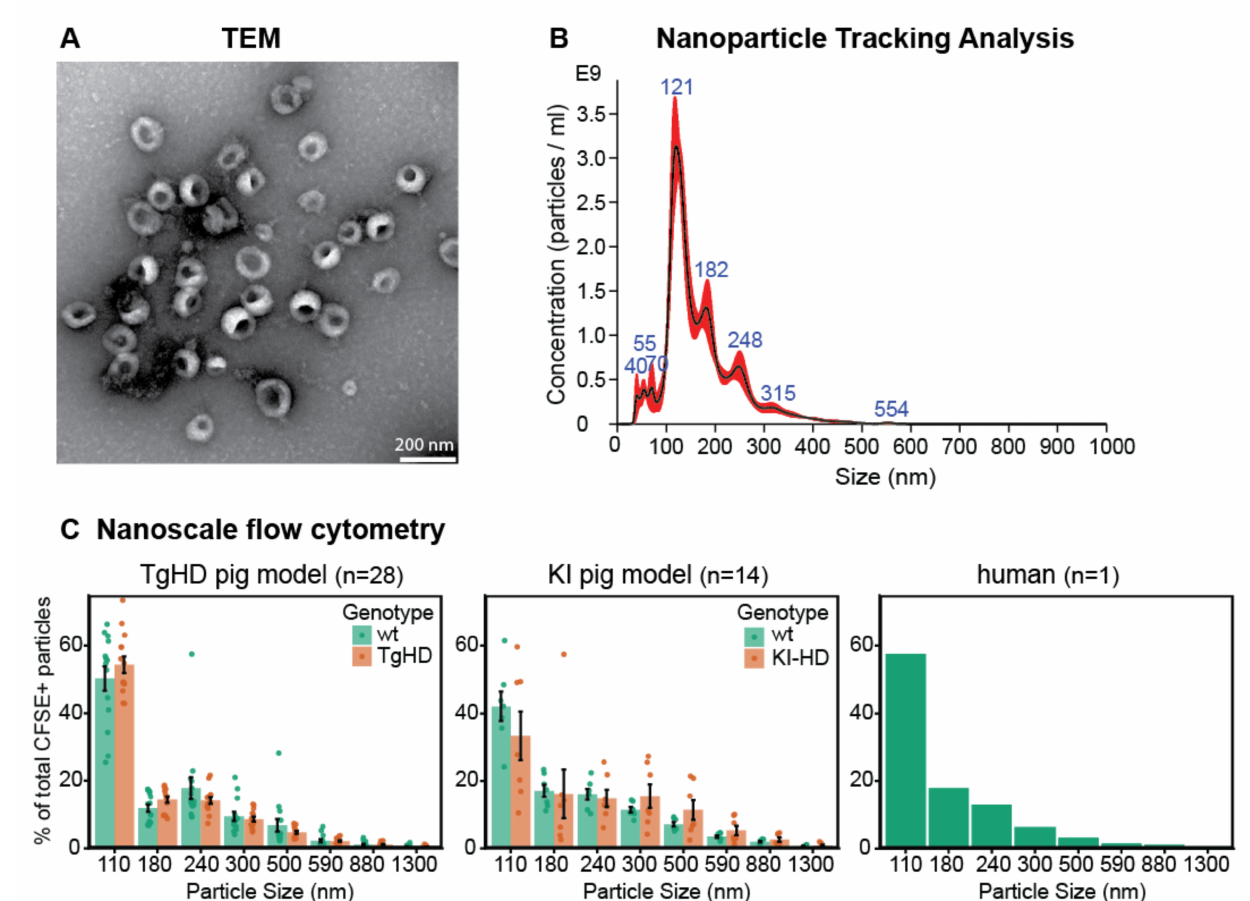
Figure 2. Characterization of the morphology and size of extracellular vesicles. ( A ) TEM confirmed presence of spherical vesicles with diameter smaller than 200 nm in the ultracentrifugation pellets from porcine and human plasma (representative image from 20 samples analyzed by TEM is shown). Magnification 100,000 × . ( B ) Characterization of particle size by NTA. Representative result from 46 samples analyzed by NTA is shown. Error bars (red) indicate ± 1 standard error of the mean (see Table S1 for detailed data). ( C ) Nanoscale flow cytometry with fluorescent CFSE labelling was used to assess size of particles of biological origin in ultracentrifugation pellets from plasma. The most frequent particle size category was 110 nm. Dots represent individual samples, bars represent mean of % of total CFSE+ particles in individual genotype and size groups, error bars show standard error of the mean (see Table S1 for detailed